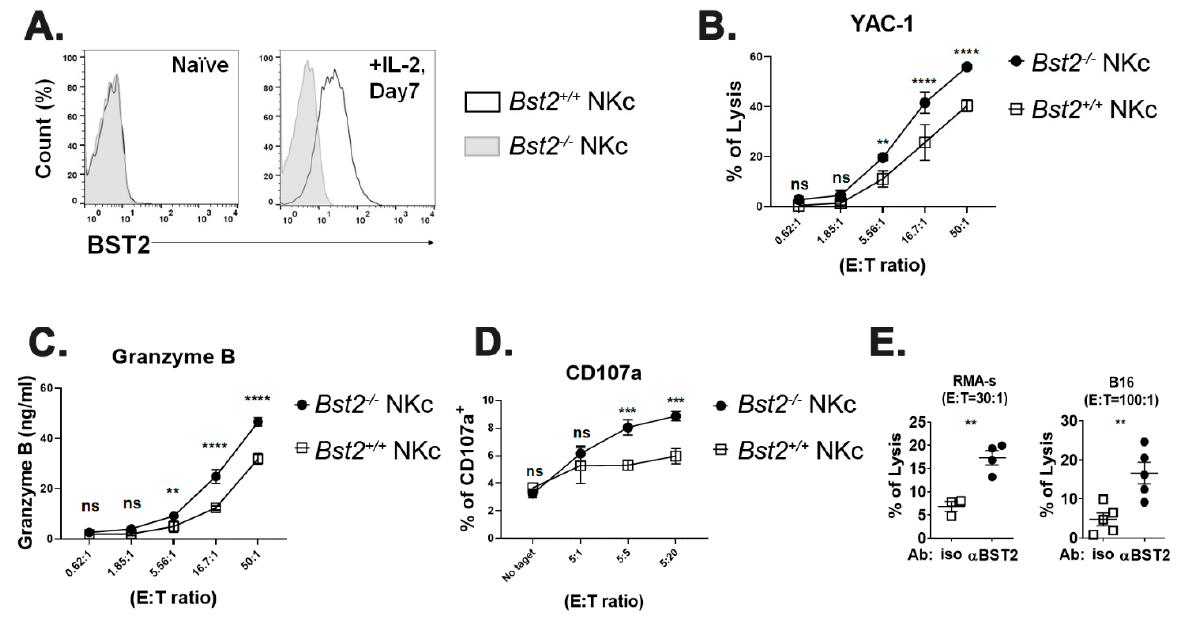
Figure 2. Bst2 -/- lymphokine activated killer cells have higher cytotoxicity to tumor cells than Bst2 +/+ LAK cells. Naïve splenocytes of B6-origin Bst2 +/+ and Bst2 -/- mice were stimulated with IL-2 for